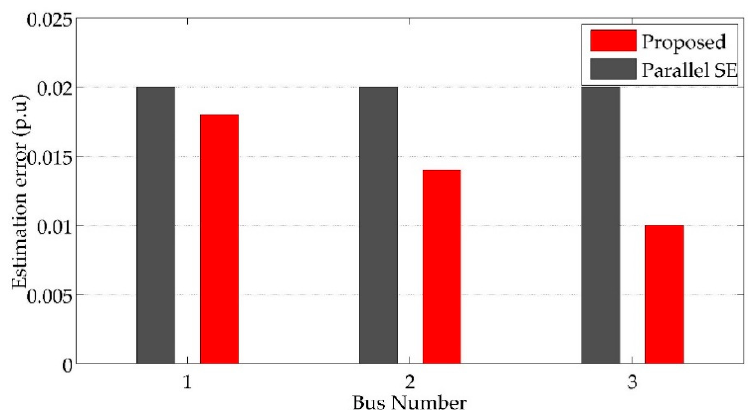
Figure 8. Analysis on the estimation error.